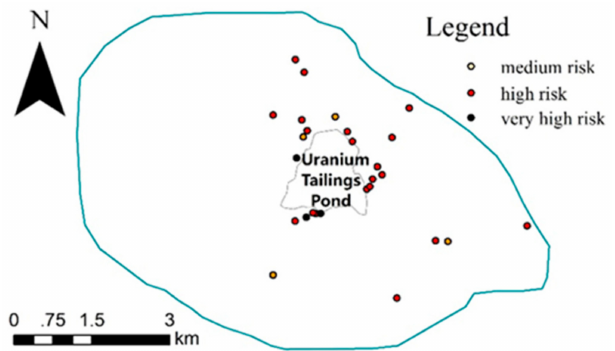
Figure 3. The distribution of the 27 samples’